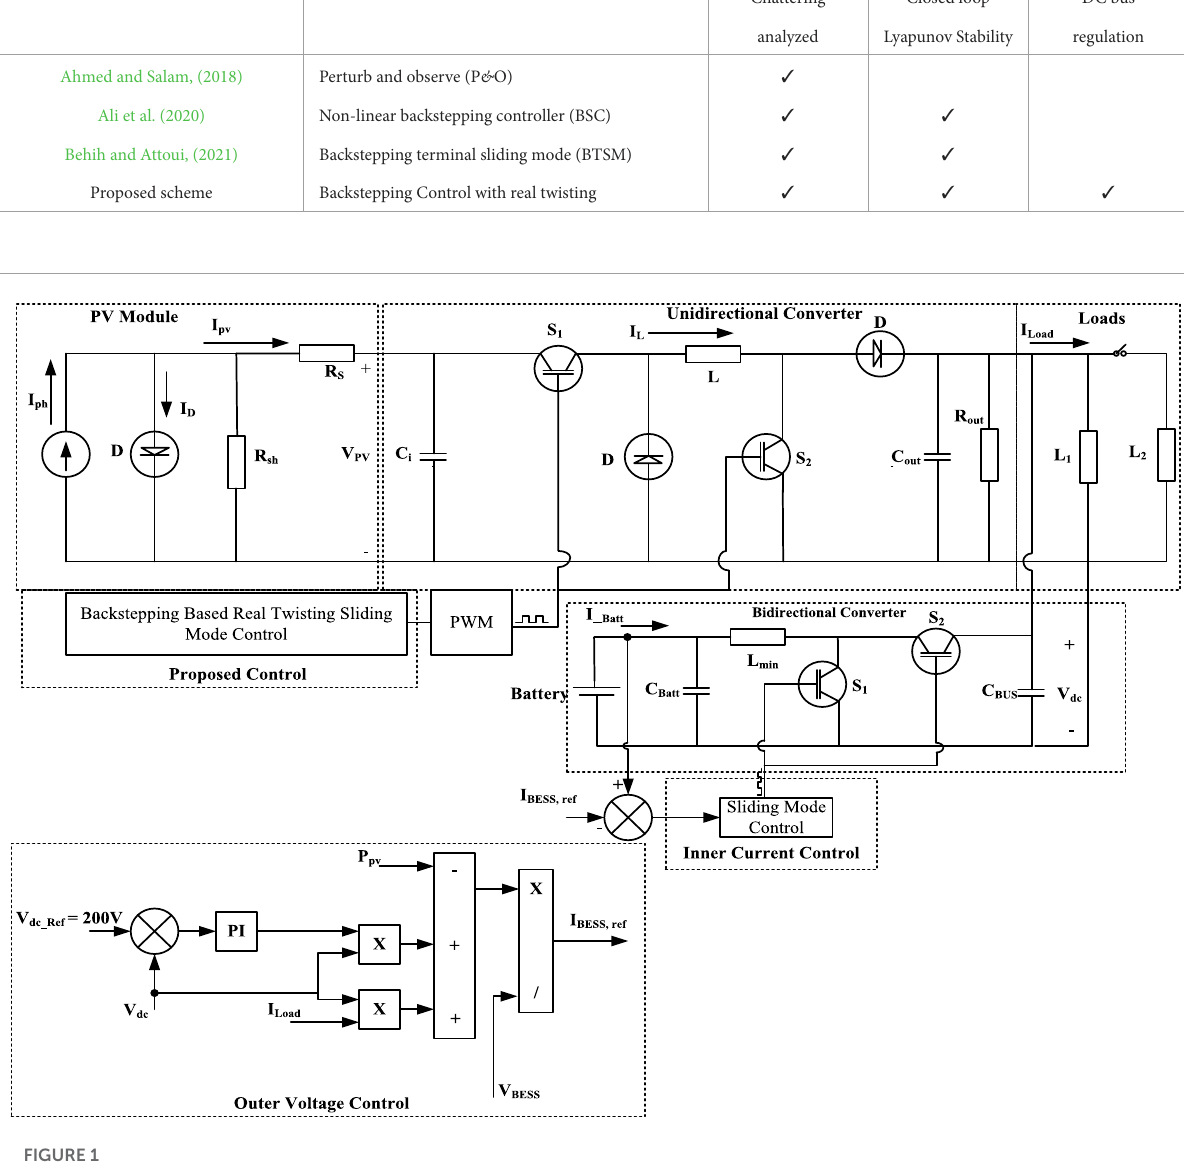
linked to DC bus via buck-boost converters. This is shown in Figure 1 . The battery buck-boost converter is bidirectional and can operate in either buck or boost mode depending on the current drawn from the source. It consists of two loops: an